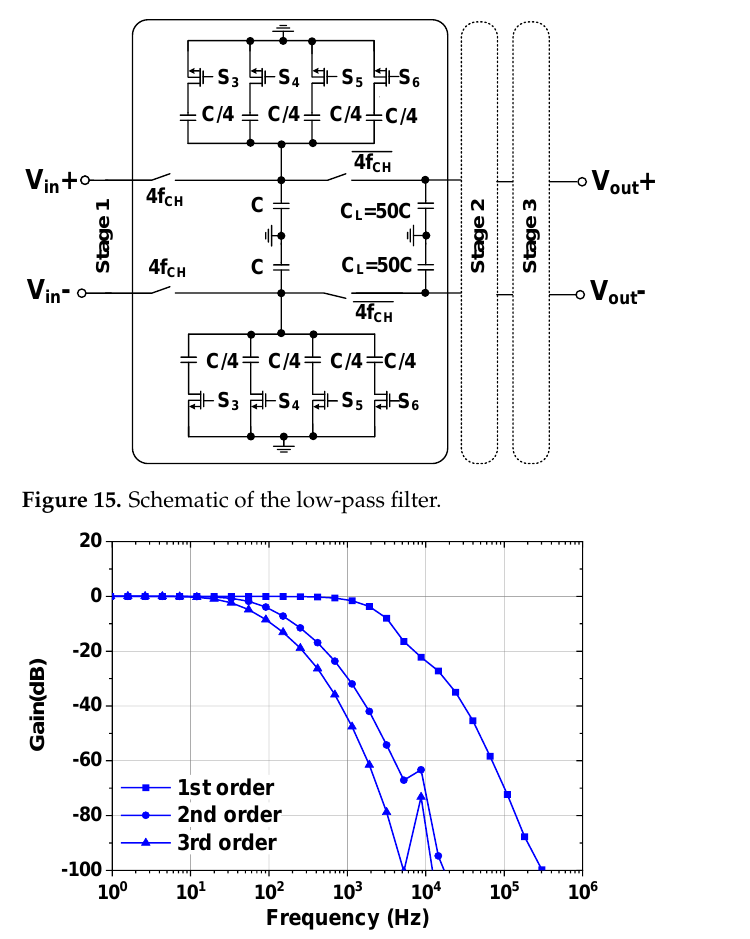
Figure 16. Simulated frequency responses of the low-pass filters.